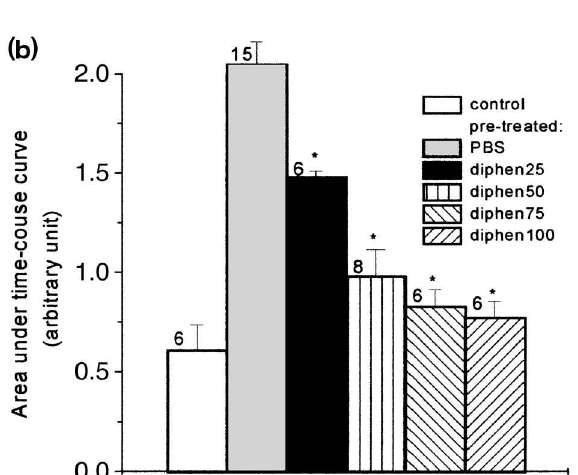
FIG. 4. Inhibition by cyproheptadine (cypro; anti-H 1 /5-HT 2 ) of rat paw oedema induced by intraplantar injection of ovalbumin (ova; 10 m g/paw) in sensitized rats. Fourteen to 18 days before, animals were sensitized with ovalbumin (30 m g/rat, i.p.) and treated 1h before intraplantar challenge, with PBS or cyproheptadines.c. at the doses indicated (mg/ kg). (a) Oedema was measured 1, 2, 3 and 4h after the inflammatory challenge and expressed as the increase in paw volume (ml) above its basal volume. (b) The area under the time-course curve was determined using a trape- zoidal rule. Each point represents the mean ± SEM for the number of animals indicated. * Significant statistical differ- ences compared with the PBS group ( p < 0.05; ANOVA, Student’s t